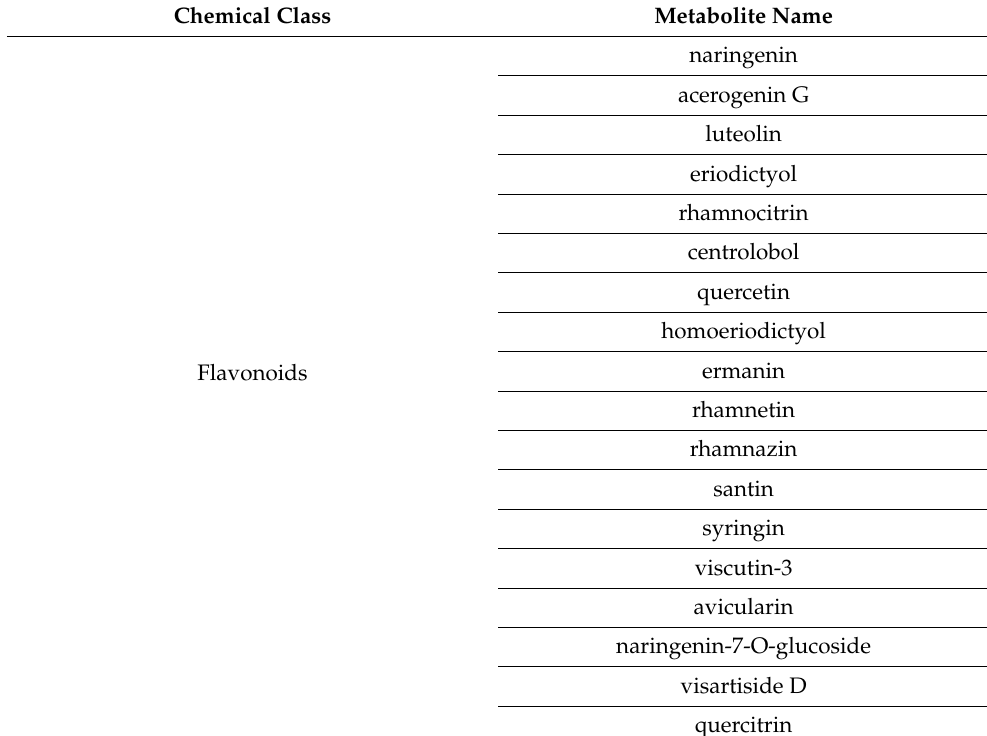
Table 2. Classification of metabolites from the Viscum album sample on different chemical